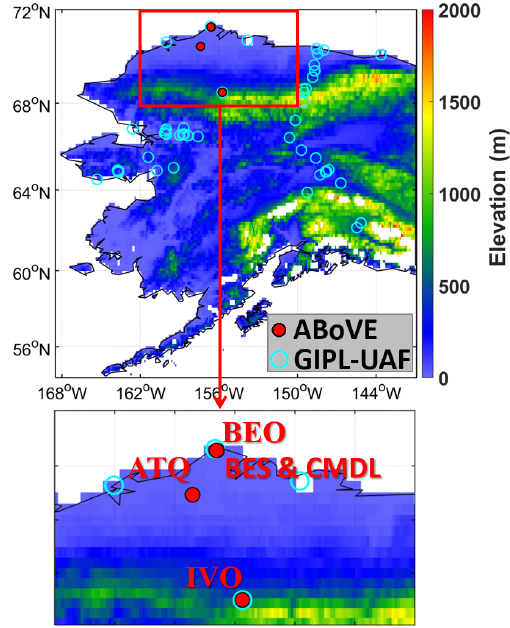
Figure 1. Red dots indicate the five ABoVE flux tower sites used in this study. Cyan circles are GIPL-UAF permafrost